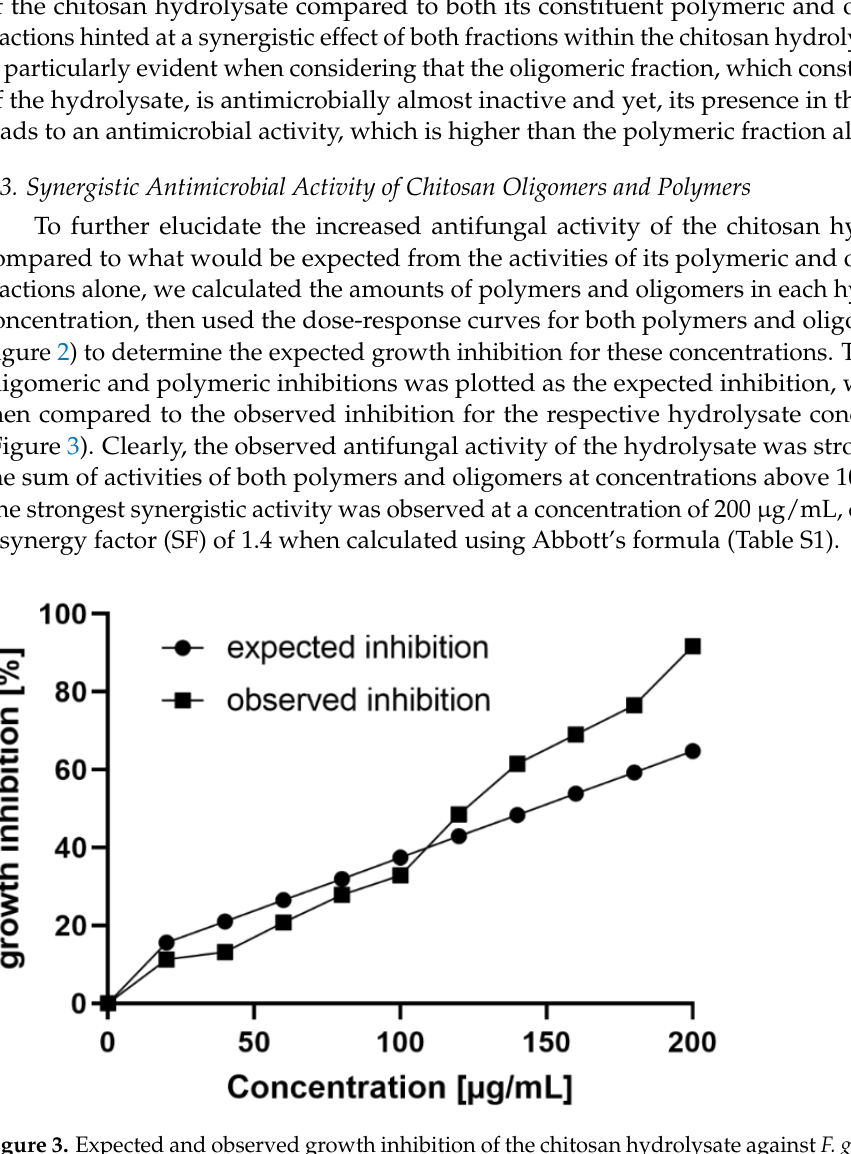
Table 2. IC 50 values of the four chitosan samples against F. graminearum . Values are taken from the experiments shown in Figure 2.